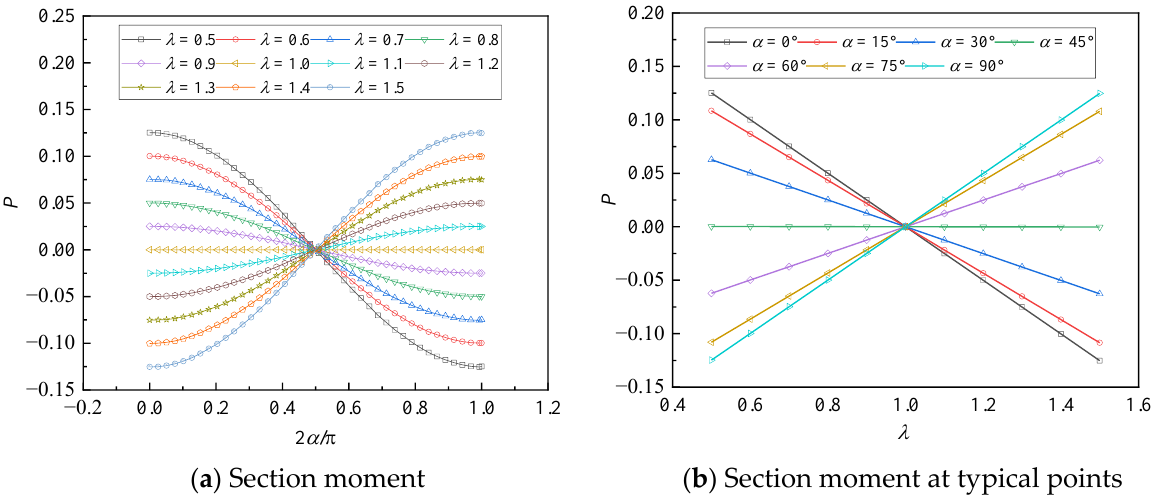
Figure 9. Section moment in the single factor test of parameter λ . From Figures 8a and 9a, the radial displacement of the lining axis and the section moment are 0 when λ = 1, which means that when the upper load is equal to the lateral load, the lining is in the safest state. When λ = 0.5~1.5 , the curves of the radial displacement and the section moment are symmetric with the curve of λ = 1 .